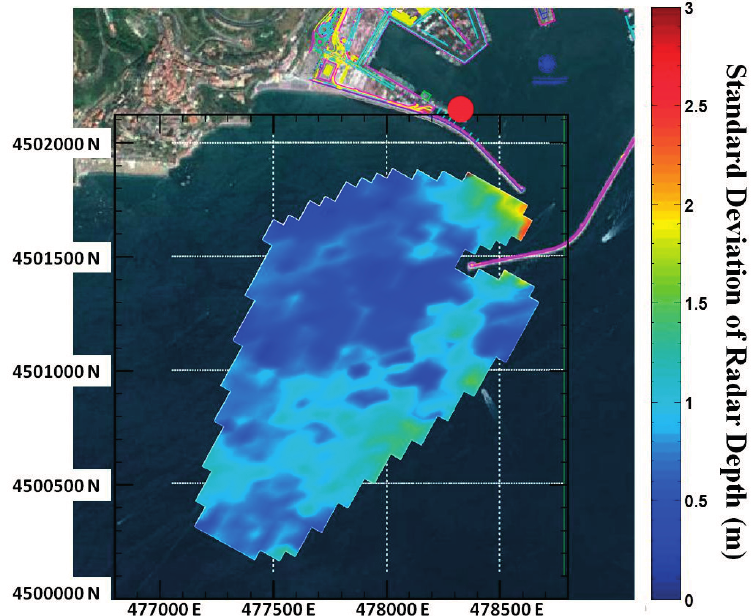
Figure 5. Standard deviation of radar bathymetry. The red circle denotes the radar